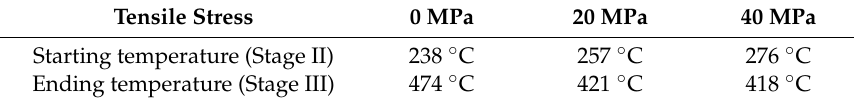
Table 2. The starting and ending temperatures of slope change under different tensile stress.